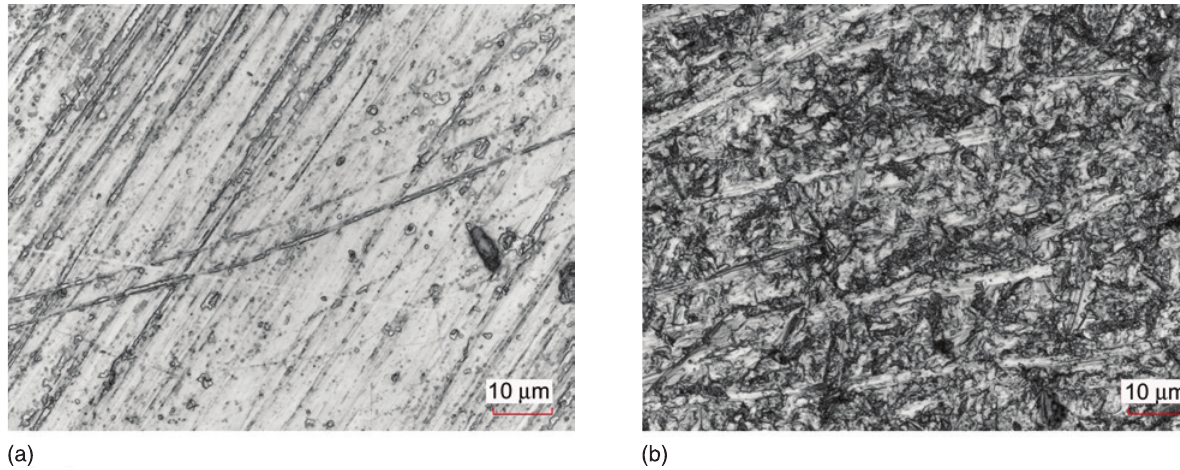
Fig. 1: Scanning laser microscopy images for alloy: a) before modification, b) modified with SiC x N y (H) layer (series 3).